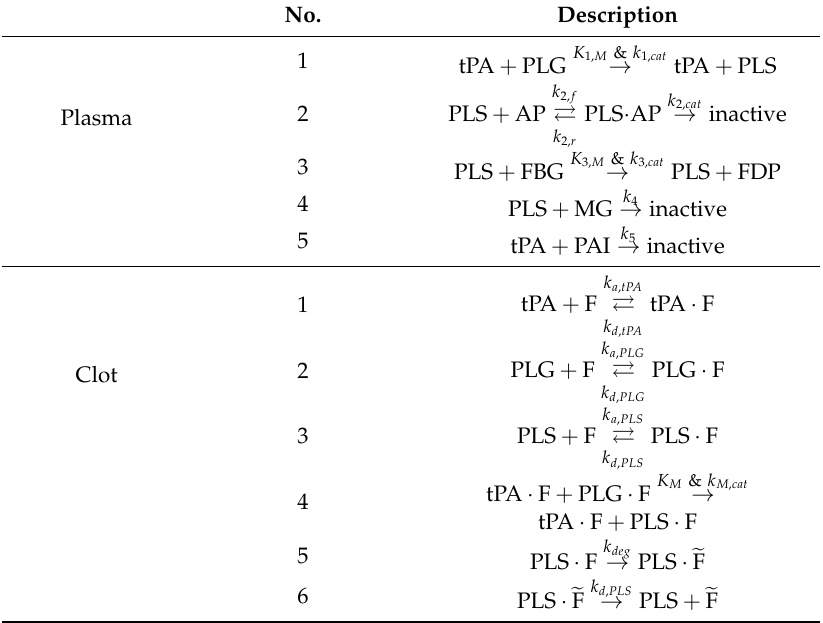
Table 1. List of reactions between fibrinolytic proteins in the plasma and clot. No.